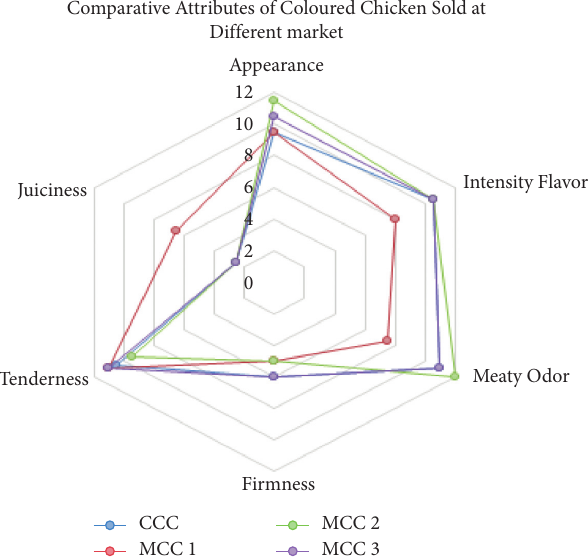
Figure 6: Spider plot of comparative attributes of colored chicken sold at different markets. CCC, control colored chicken; MCC, market colored